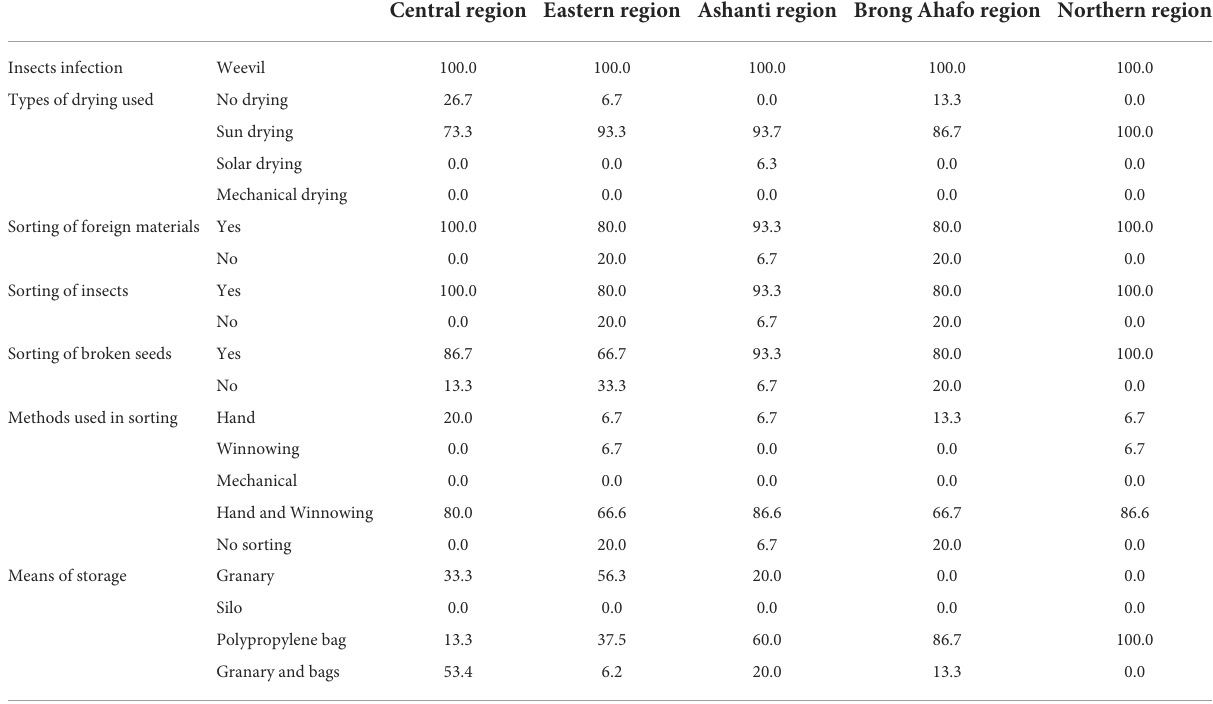
TABLE 6 Post-harvest techniques practiced by maize farmers.